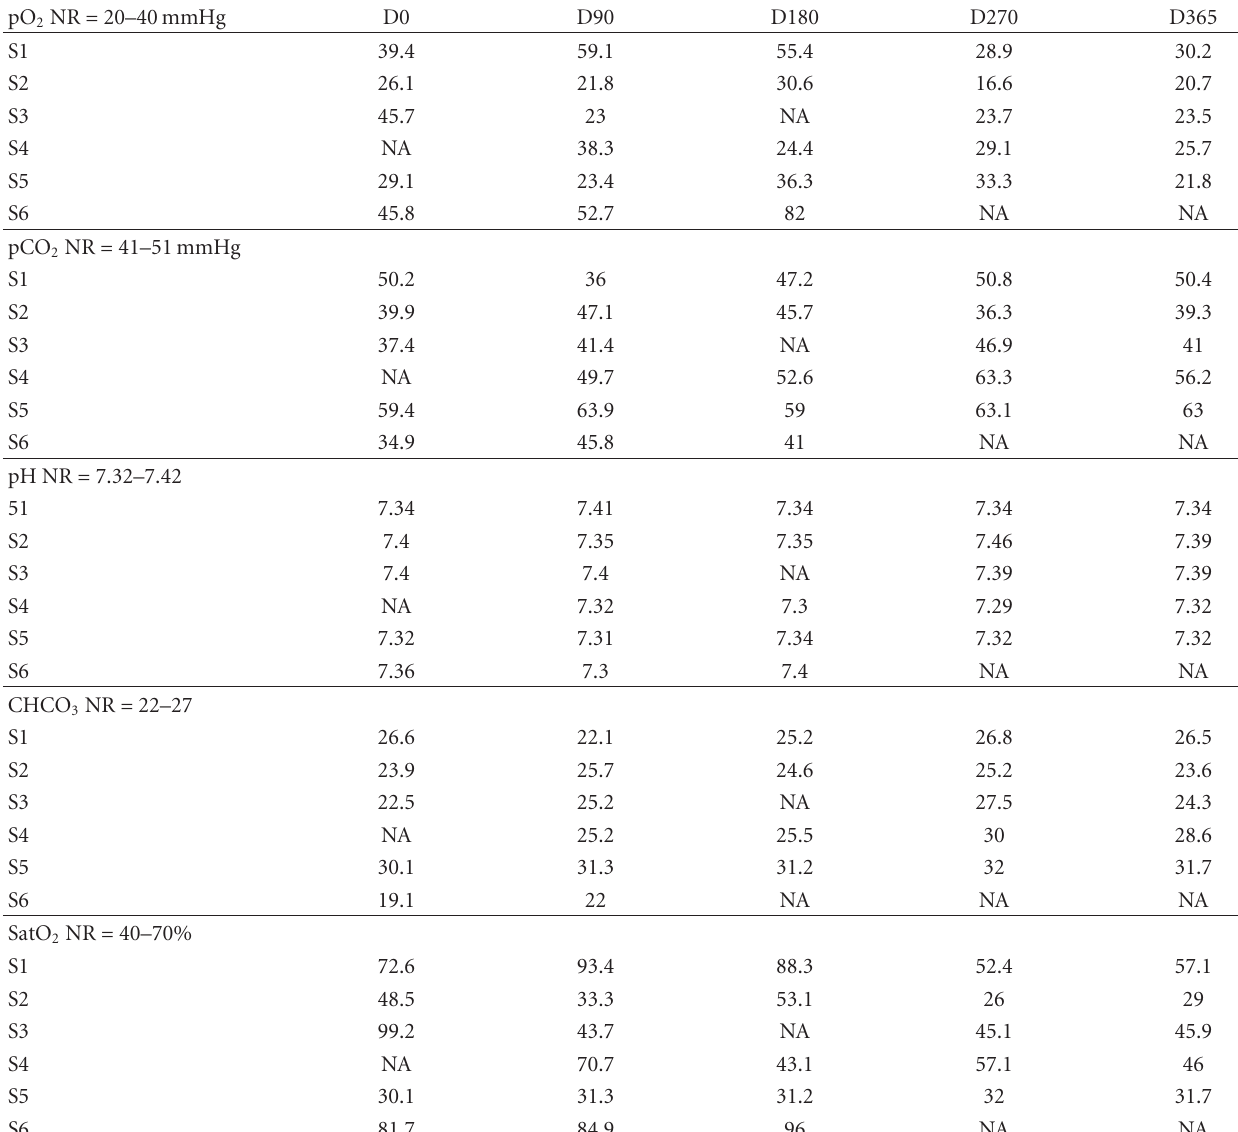
Table 2: Gas parameters. This table reports the measurements of gas parameters for each patient at D0 and following hospitalization. NR: not registered. NA: not